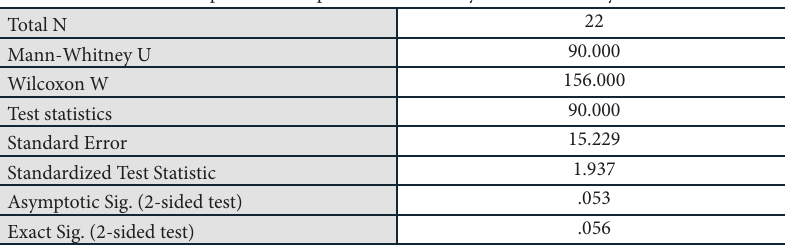
Figure 6: Execution time analysis information of diferent methods in the Mann ‒ Whitney U